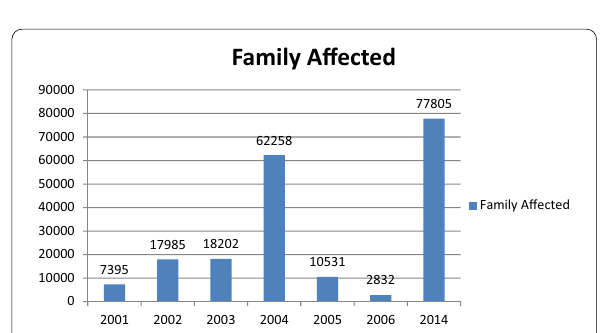
Fig. 4 Year-wise family affected in Assam due flood and Riverbank erosion. Source: Water Resource Department, GOA